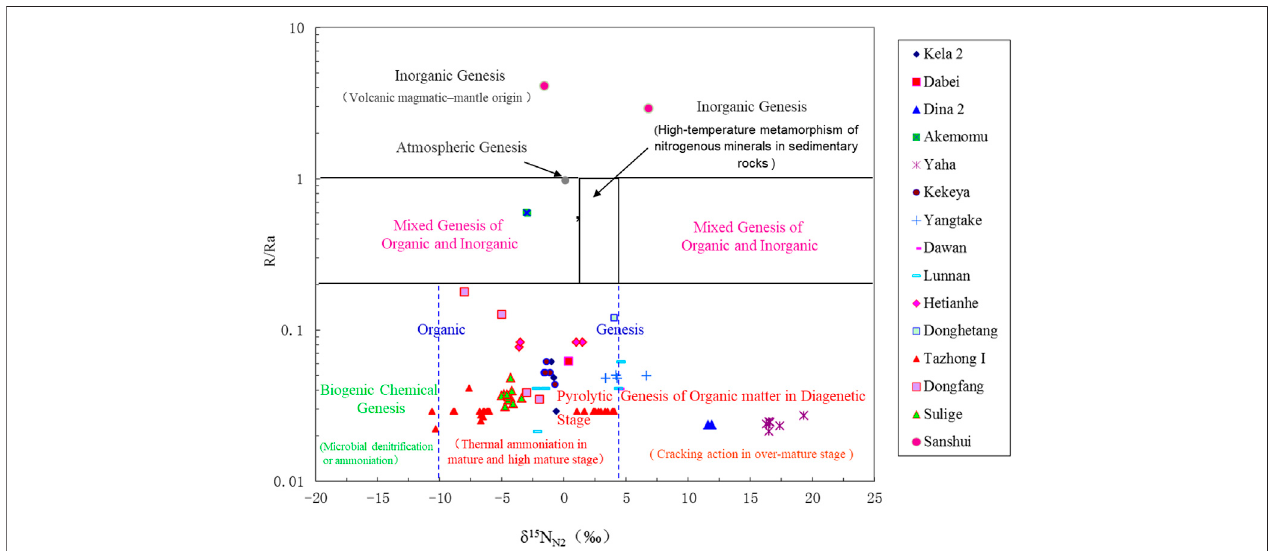
FIGURE 7 | Genesis identi fi cation chart of R/Ra- δ 15 N for organic and inorganic nitrogen in natural gases in China.